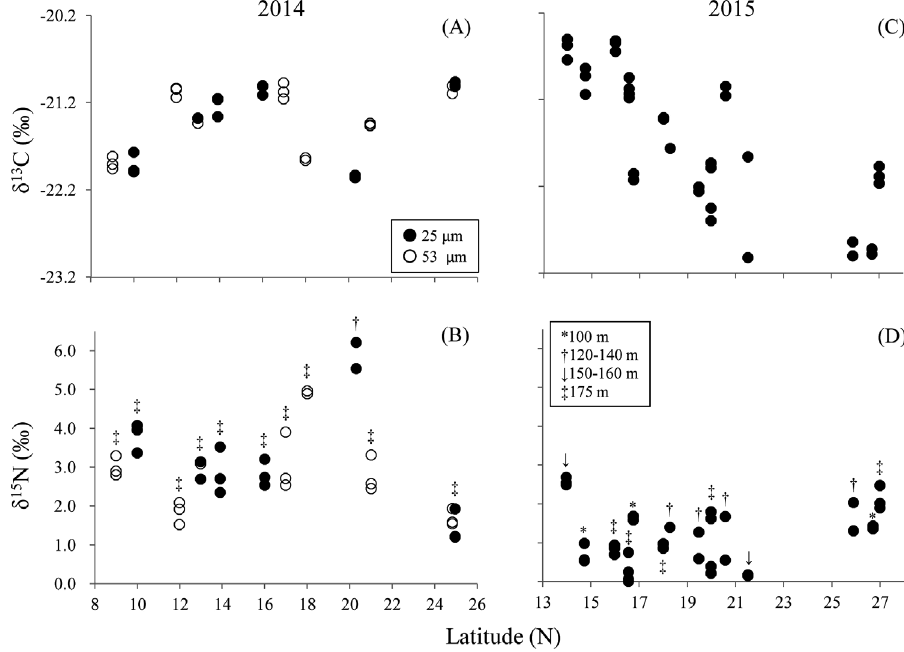
Fig. 6. d 13 C (A, C) and d 15 N (B, D) of POMEW samples plotted against latitude in 2014 (A, B) and 2015 (C, D). Open and closed circles indicate POMEW samples fi ltered through 53 and 25 m m meshes, respectively. Symbols on the plots indicate set depth of the MS